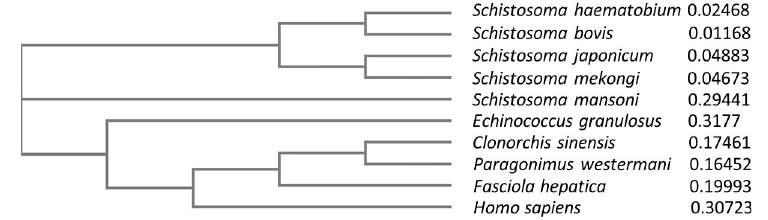
Fig 8. Phylogenetic tree of Fatty acid amide hydrolase from S . mekongi , other trematode species, cestode, and human. Five species of schistosome are grouped together and are distant from human.